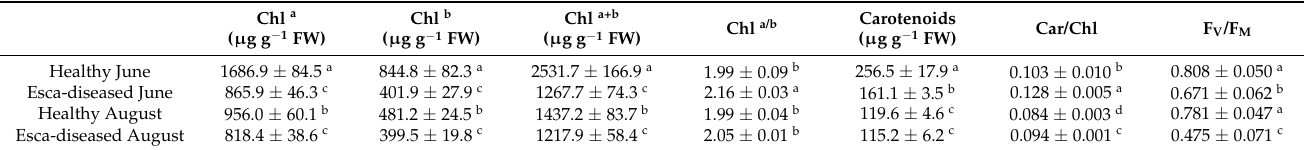
Table 3. Effect of esca on the chlorophyll a and b and total chlorophyll contents, chlorophyll a/b ratio, total carotenoids, carotenoid/chlorophyll ratio, and photosynthetic efficiency (F V /F M ) in leaves of Vitis vinifera cv.